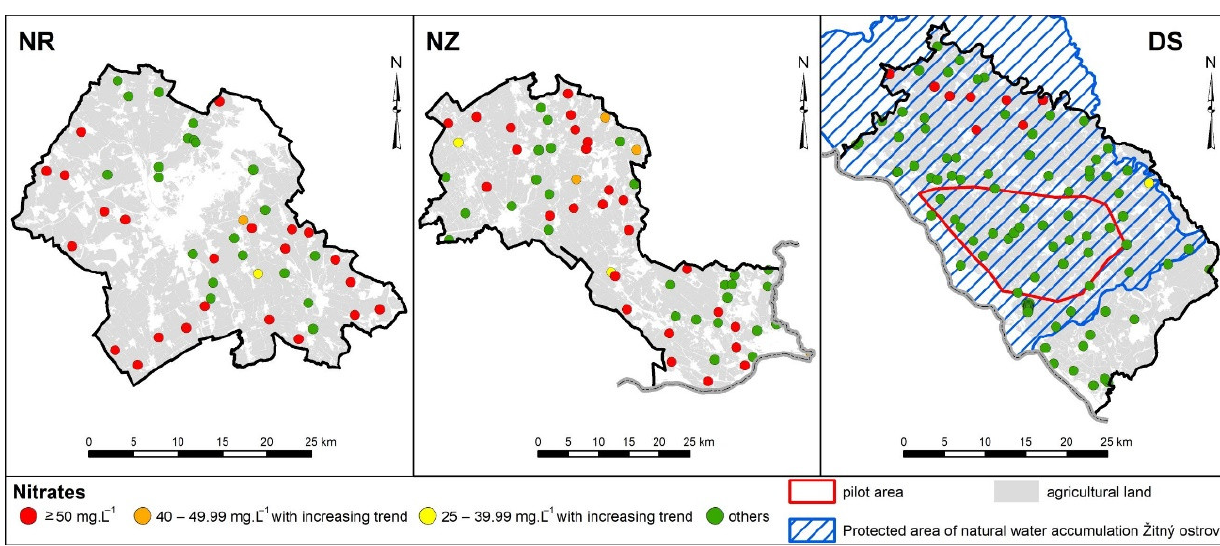
Figure 1. Spatial distribution of defined average nitrate concentrations in groundwater in 2016–2019 and allocation of selected districts.